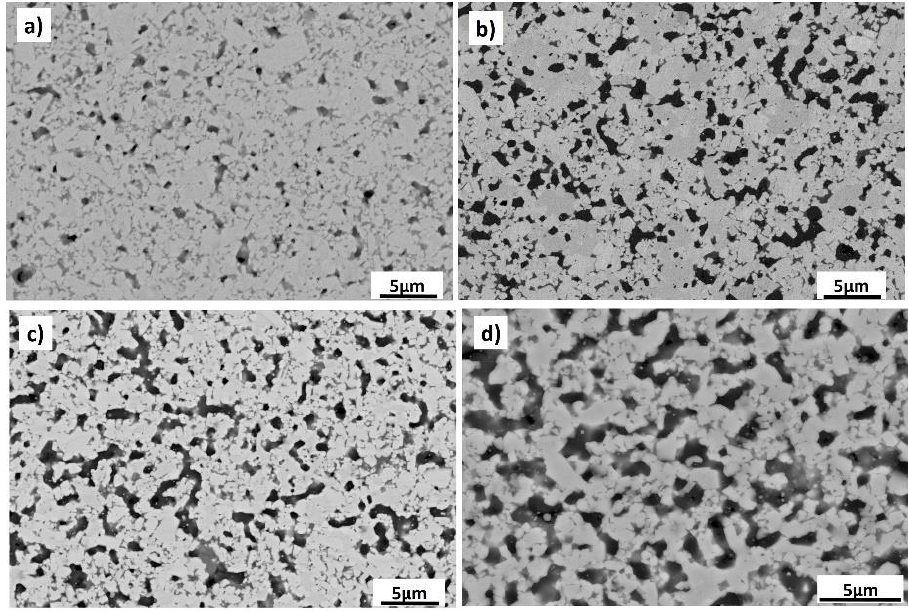
Figure 11. SEM micrographs of the consolidated WC-Co-TaC-NbC samples with 5 wt% Ni and different wt% Y 2 O 3 : ( a ) 2.5 wt% Y 2 O 3 , ( b ) 5 wt% Y 2 O 3 , ( c ) 7.5 wt% Y 2 O 3 , ( d ) 10 wt% Y 2 O 3 .